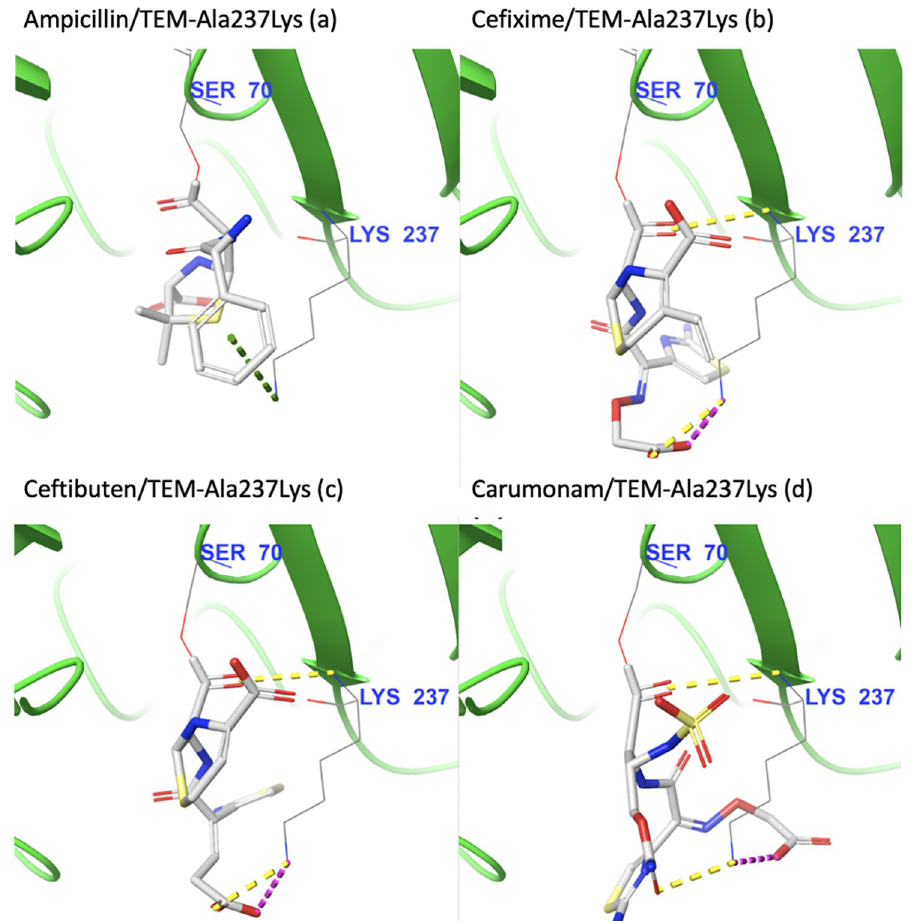
Fig 11. Visual inspection of the intermolecular interactions with Lys237 for ligands covalently bound to TEM-Ala237Lys. (a) Ampicillin, (b) Cefixime, (c) Ceftibuten, and (d) Carumonam. Yellow dotted lines indicate hydrogen interactions, orange dotted lines indicate poor contacts/clashes, purple dotted lines indicate salt bridges, and green dotted lines indicate cation-pi interactions.